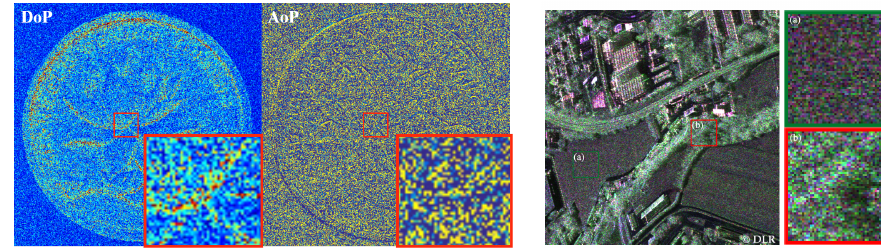
Figure 12. ( Left ) Noisy images of DoP/AoP ( Right ) F-SAR airborne image